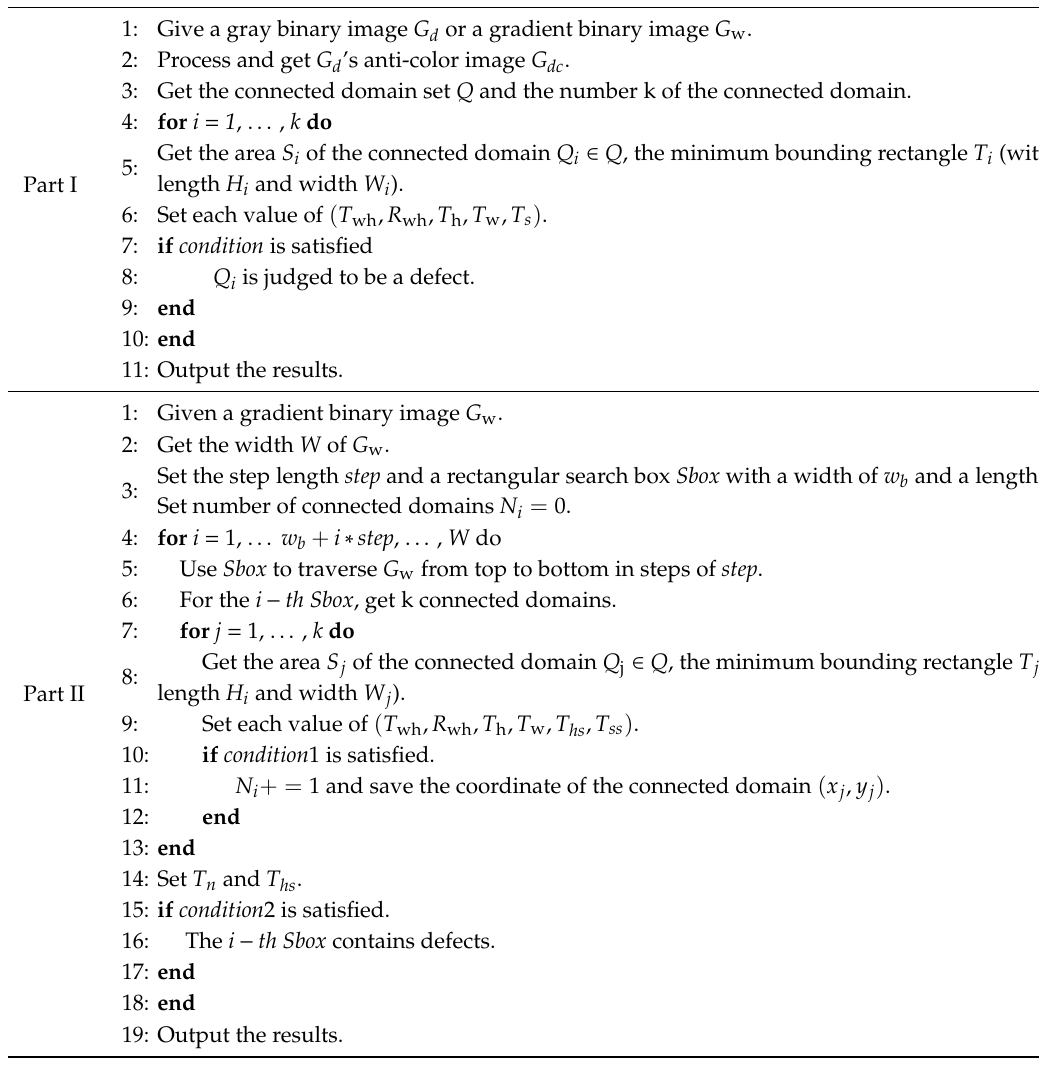
Algorithm 3 Connected Domain Filtering